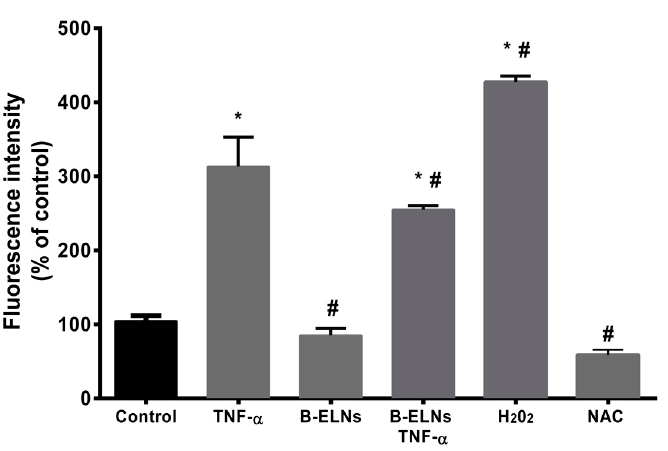
Figure 5. Intracellular reactive oxygen species (ROS) production in EA.hy926 cells pretreated with B-ELNs (20 µ g / mL) for 3 h, and then exposed to TNF- α (20 ng / mL) for 2 h. Vehicle-treated cells were used as controls. Cells exposed to 50 µ M of H 2 0 2 for 1 h were used as positive control of increased intra-cellular ROS level, while cells treated with 200 µ M N-acetyl-l-cysteine (NAC) as negative control. Results are expressed as relative ethidium fluorescent intensity (percentage of control), and are reported as mean ± SD of three separate experiments. * p < 0.05 vs. control; # p < 0.05 vs. control treated with TNF- α .